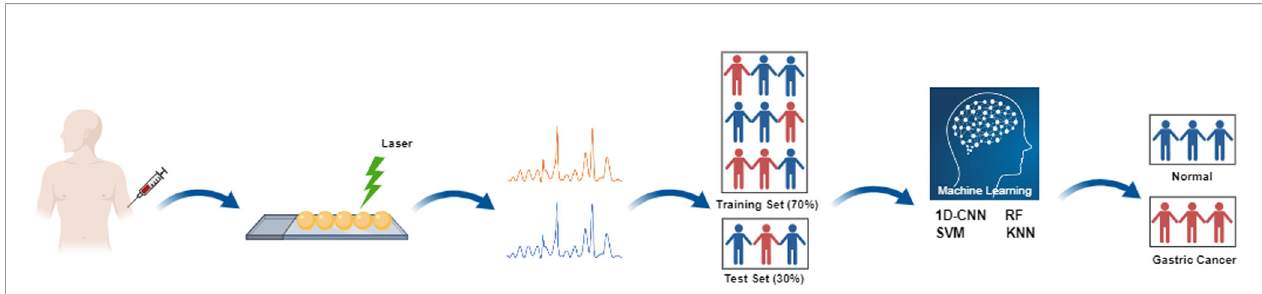
FIGURE 1 | Flow chart of serum Raman spectroscopy combined with different machine learning methods for non-invasive screening of gastric cancer. Four popular and high-performance machine learning methods include one-dimensional convolutional neural network (1D-CNN), random forest (RF), support vector machine (SVM), and k-nearest neighbor